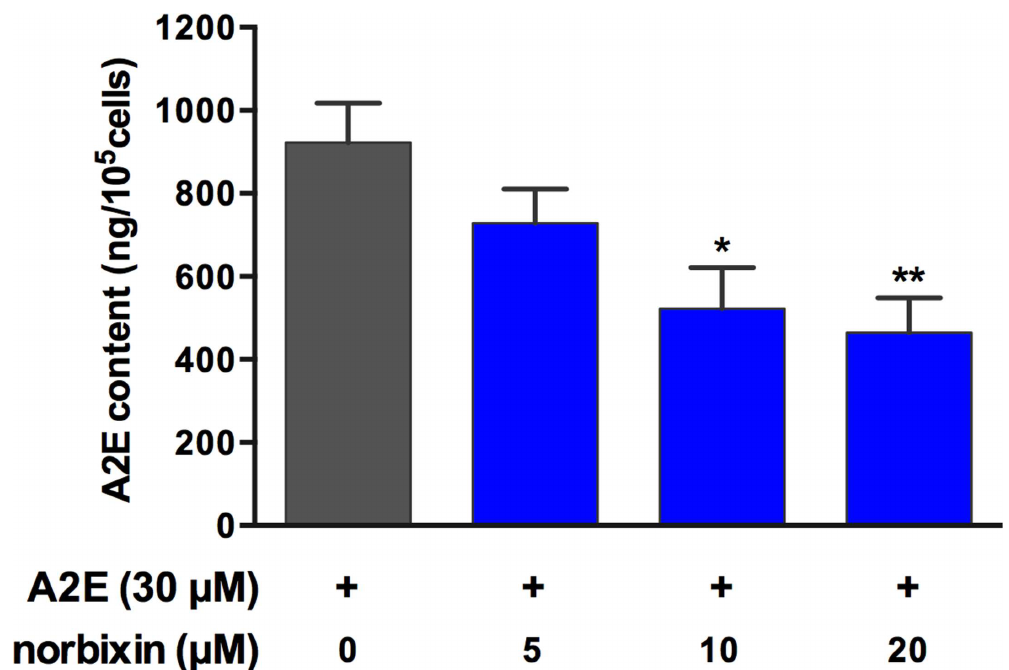
Fig 9. Effect of different concentrations of norbixin on the accumulation of A2E by porcine RPE cells in vitro . RPE cells were treated with norbixin(or DMSO) and with A2E but not illuminatedand cells were extracted with MeOH. A2E concentrations are expressedas absoluteamounts per 10 5 cells. Bars representthe mean ± s.e. m. of three separate experiments with n = 3. ** p < 0.01, *** p < 0.001comparedto cells non treated with norbixin (One-wayANOVA, Dunnett’s post test).